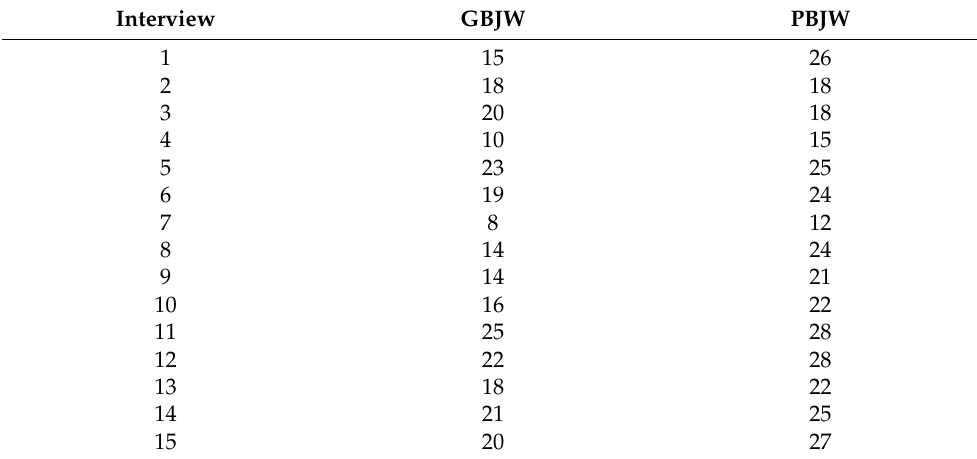
Table 5. General and Personal Belief in a Just World Scale